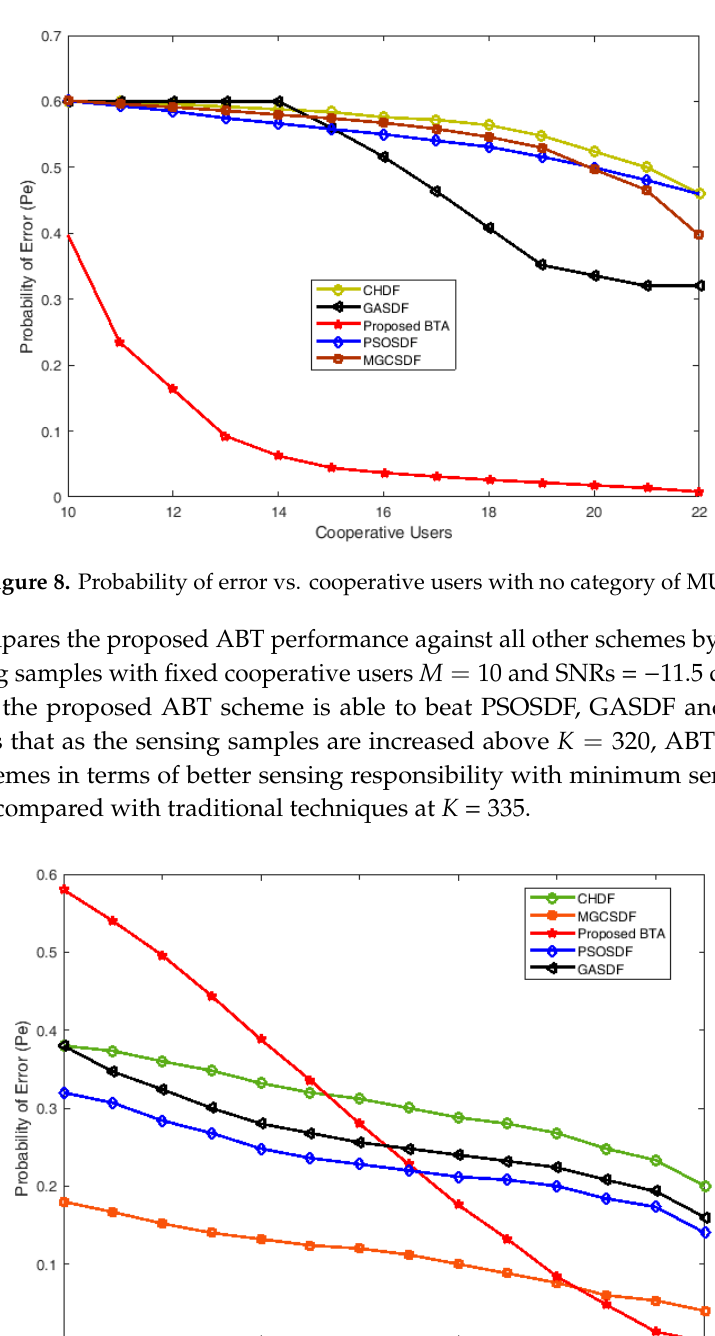
Figure 9. Probability of error vs. sensing samples under no users.